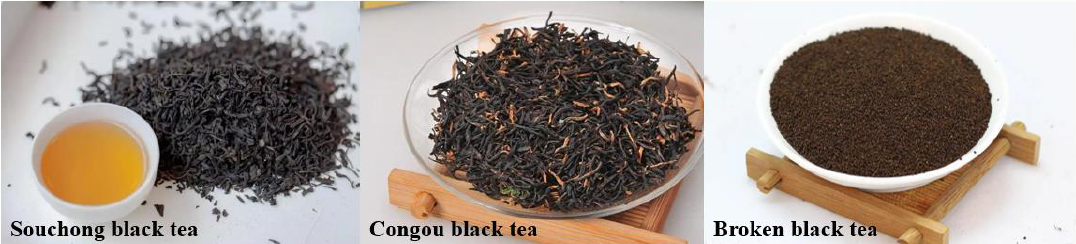
Figure 1. Different types of Chinese black tea.